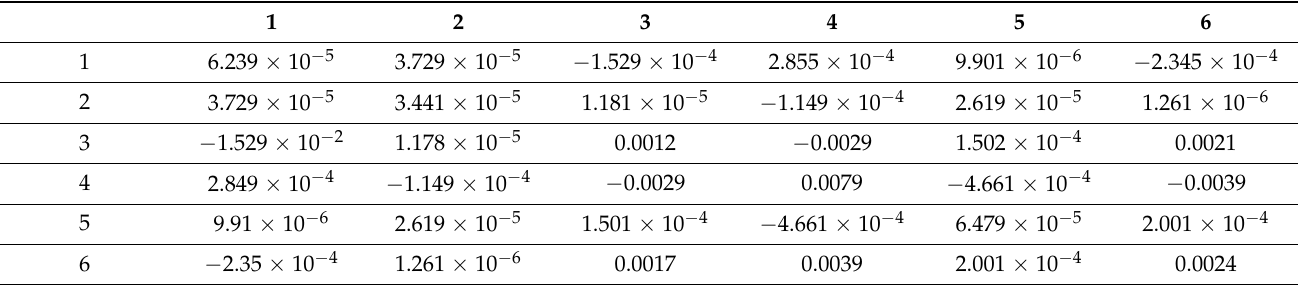
Table 3. Sample covariance matrix data.